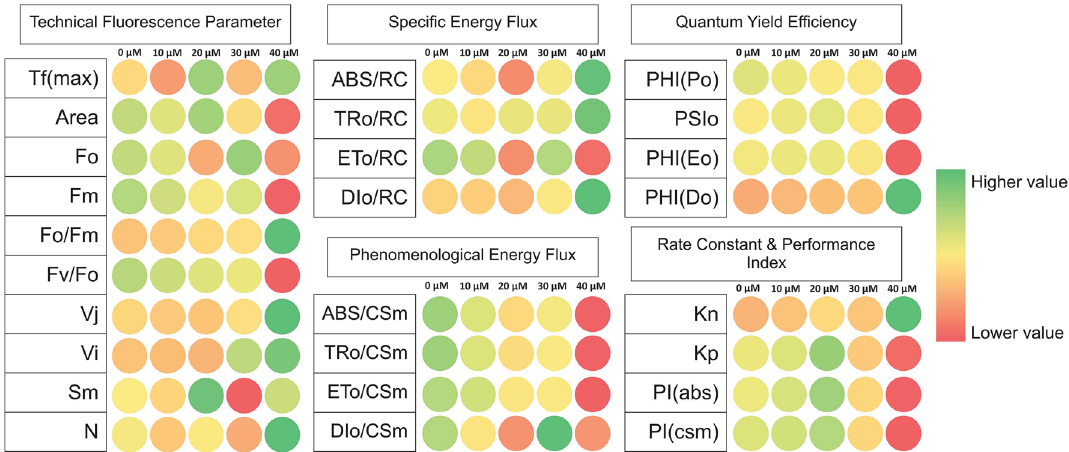
Figure 3. Heat map represents relative variability of several photosynthesis-related parameters, obtained after using the JIP test for L. minor under Cu stress. Data are for different concentrations (0.0 µM to 40.0 µM), obtained after 24 h red is for lower value (1%), yellow for medium (50%), and green for the highest values (100%) All the data obtained were first normalized to bring the value of the parameters in the range of 1–100 to provide an unbiased colour code.